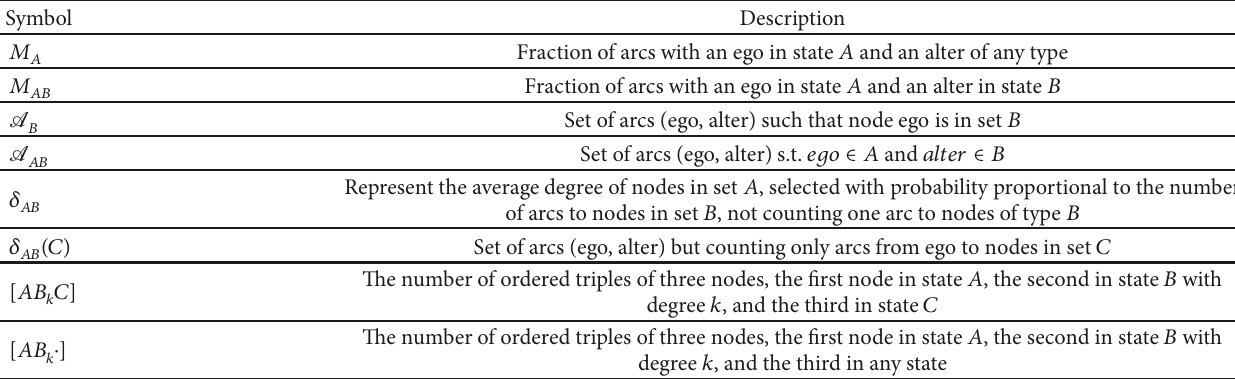
Table 1: Key variables and parameters. Symbol Description